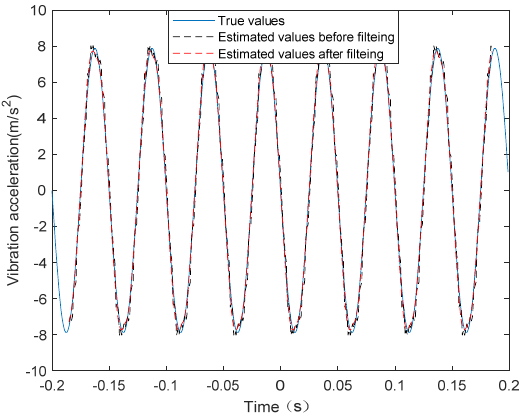
Figure 3. Real and estimated values of high-frequency vibration acceleration.